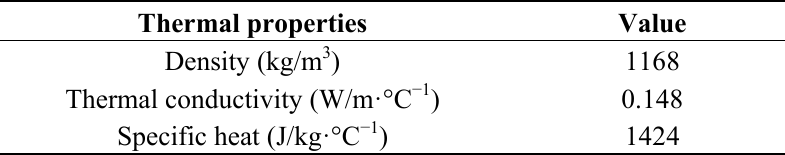
Table 2. Thermal properties of